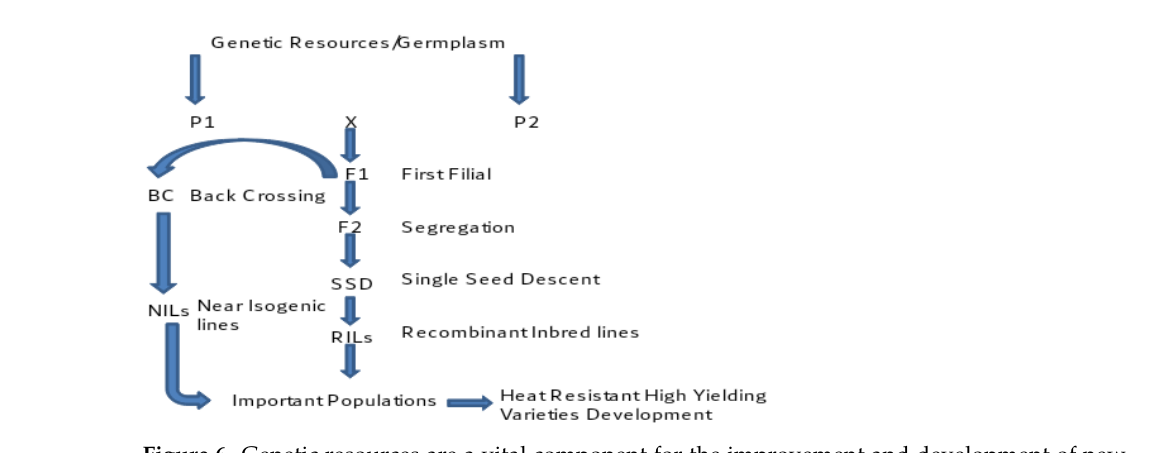
Table S2: (Part-I): Mean of Paddy Yield (kg/ha) of Rice Hybrids Evaluated in NUYT during Kharif, 2021, (Part-II) Quality Characteristics of Rice Hybrids Evaluated in NUYT 2021; Table S3: SSR markers used for rice hybrids for their Genetic diversity